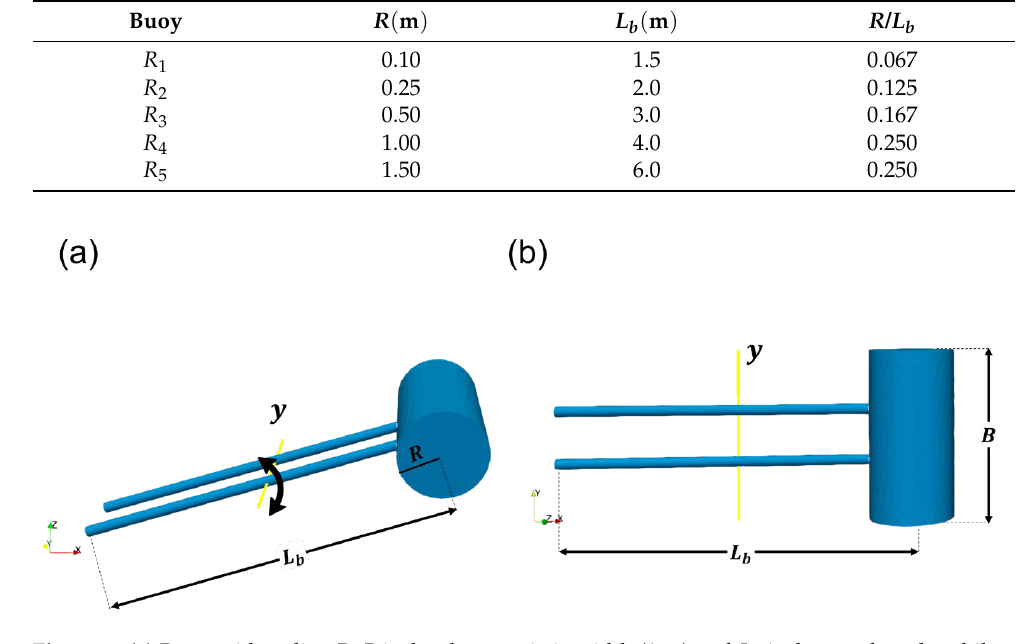
Figure 2. ( a ) Buoy with radius R ; B is the characteristic width (1 m) and L b is the arm length, while y is the rotation axis. ( b ) Top view of the buoy. Table 2. Tested values for the buoy’s radius ® and its arm length (